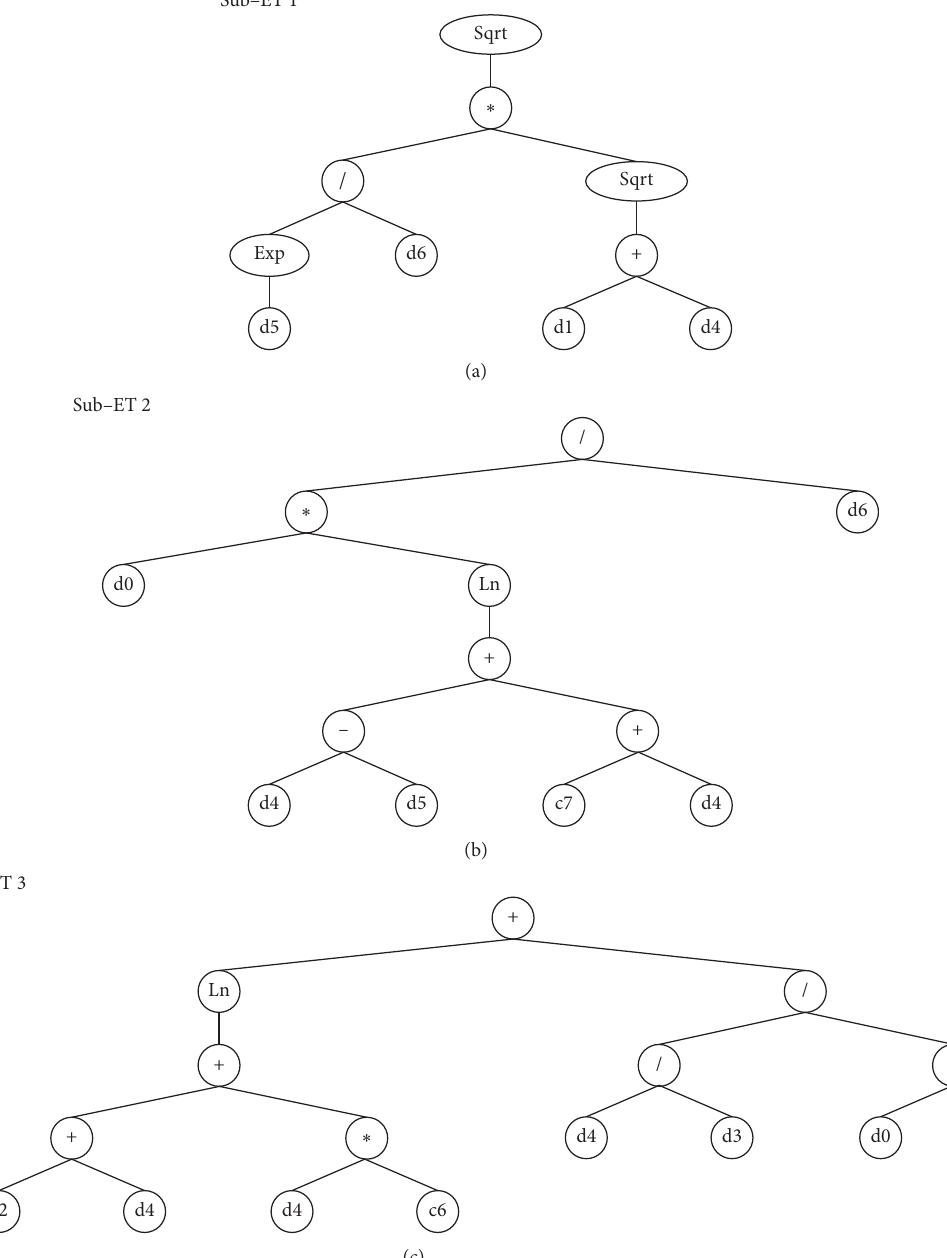
Figure 9: Expression tree of the model formulated for R value (where d0: HARHA, d1: w ET2 C7: 1.4413, Sub-ET3 C2: -12.398, Sub-ET3 C6: